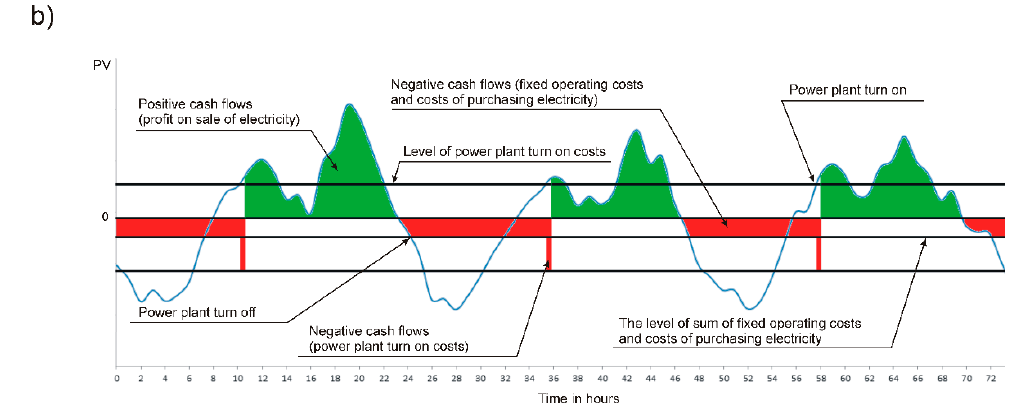
Figure 1. Cash flows from operating activities generated by the gas-fired unit; ( a ) continuous operation (base model); ( b ) flexible operation (with switching option).